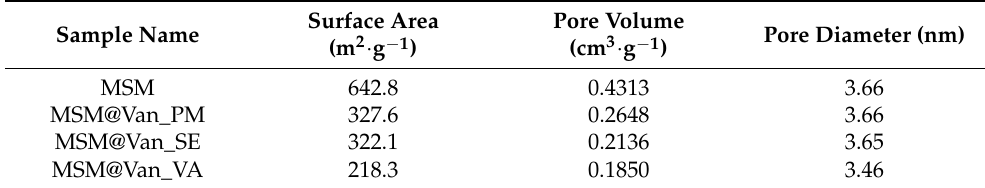
Figure 4. N 2 adsorption/desorption isotherms and corresponding pore size distributions for ( a ) un- loaded MSM, and loaded MSMs by ( b ) physical mixing, ( c ) solvent evaporation, and ( d ) vacuum- assisted method. Table 2. Textural characteristics of unloaded MSM and vancomycin loaded MSMs according to physisorption curves.